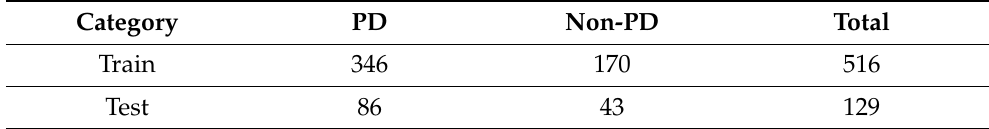
Table 2. Dataset